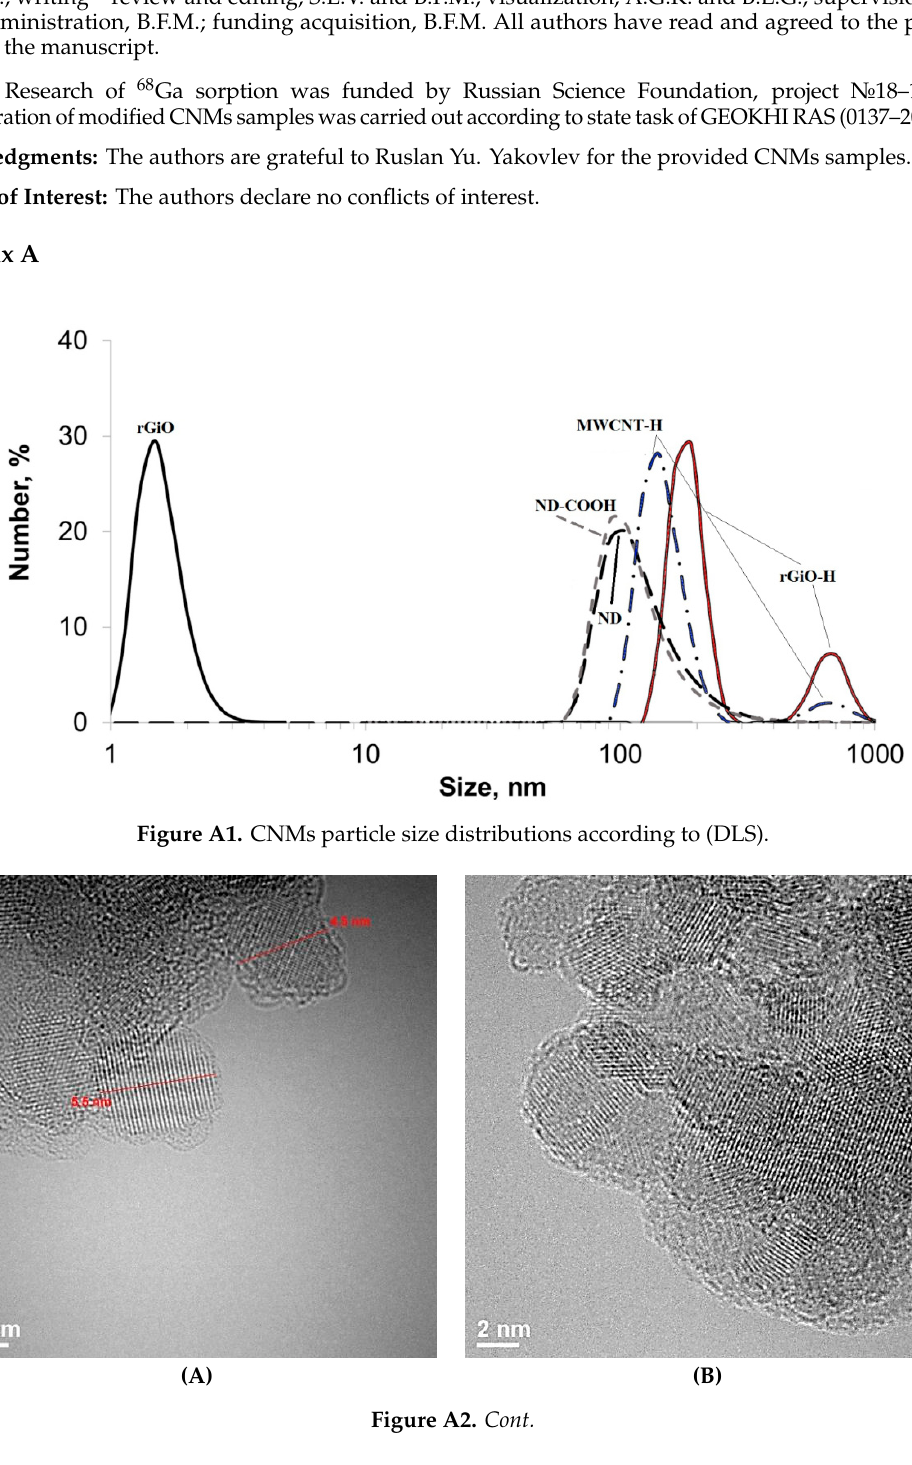
Figure A2. HRTEM images of commercial CNMs used: ND ( A , B ), rGiO ( C , D ), multi-walled carbon nanotubes (MWCNT) ( E , F ); images are similar to ones for modified samples ND–COOH, rGiO–H and MWCNT–H, respectively. Adapted from [Kazakov, A.G.; Garashchenko, B.L.; Yakovlev, R.Y.; Vinokurov, S.E.; Kalmykov, S.N.; Myasoedov, B.F. An experimental study of sorption/desorption of selected radionuclides on carbon nanomaterials: a quest for possible applications in future nuclear medicine. Diam. Relat. Mater. 2020, 104, 107752, doi:10.1016/j.diamond.2020.107752.] with permission from Elsevier B.V., 2020.